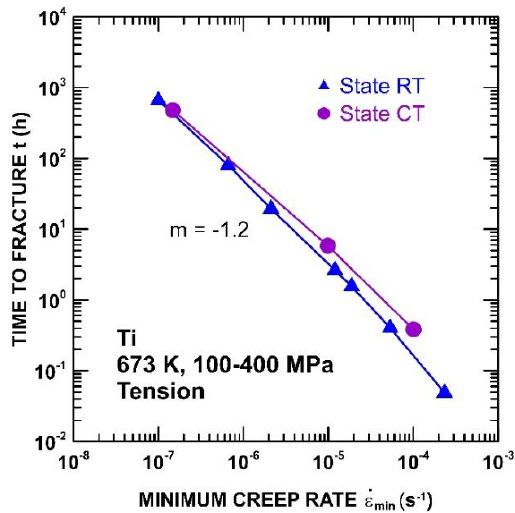
Figure 4. Monkman–Grant relationships determined for RT and CT states at 673